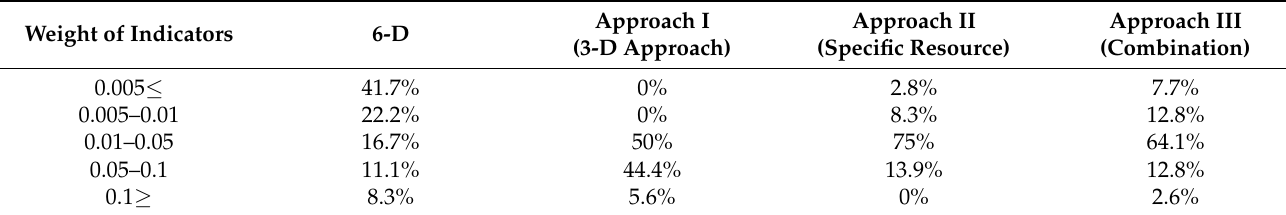
Figure 3. Determined criteria weight (6-D).